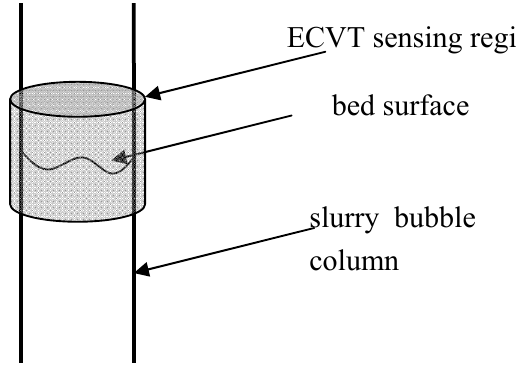
Figure 17. Sketch of an ECVT sensor monitoring the bed surface in a slurry bubble column.